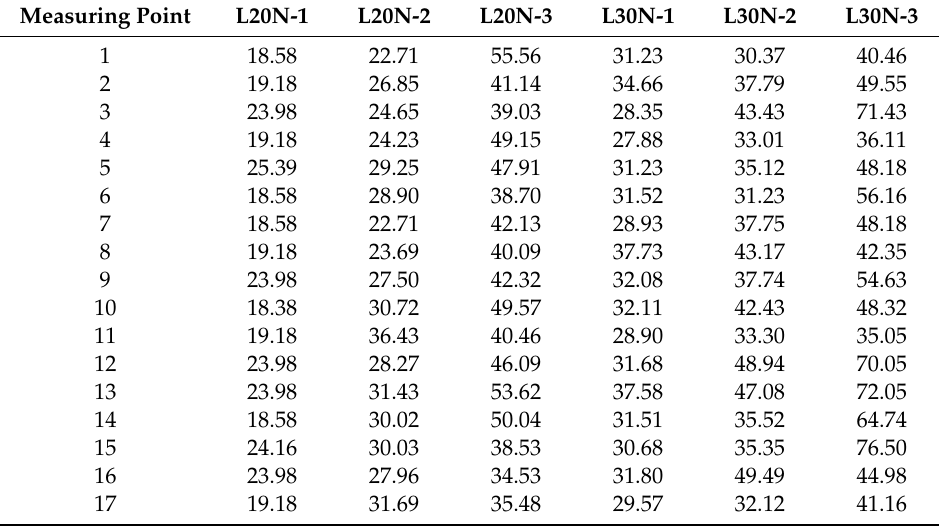
Table A3. The characteristic contour parameter